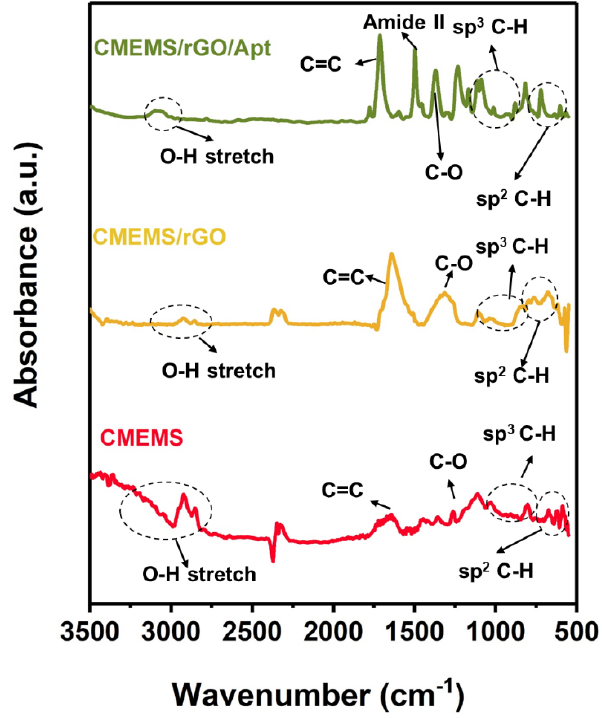
Figure 4. FTIR spectra ofCMEMS electrode before any modification, CMEMS electrode after BPE-rGO deposition (CMEMS/rGO), and CMEMS/rGO after aptamer immobilization (CMEMS/rGO/Apt).